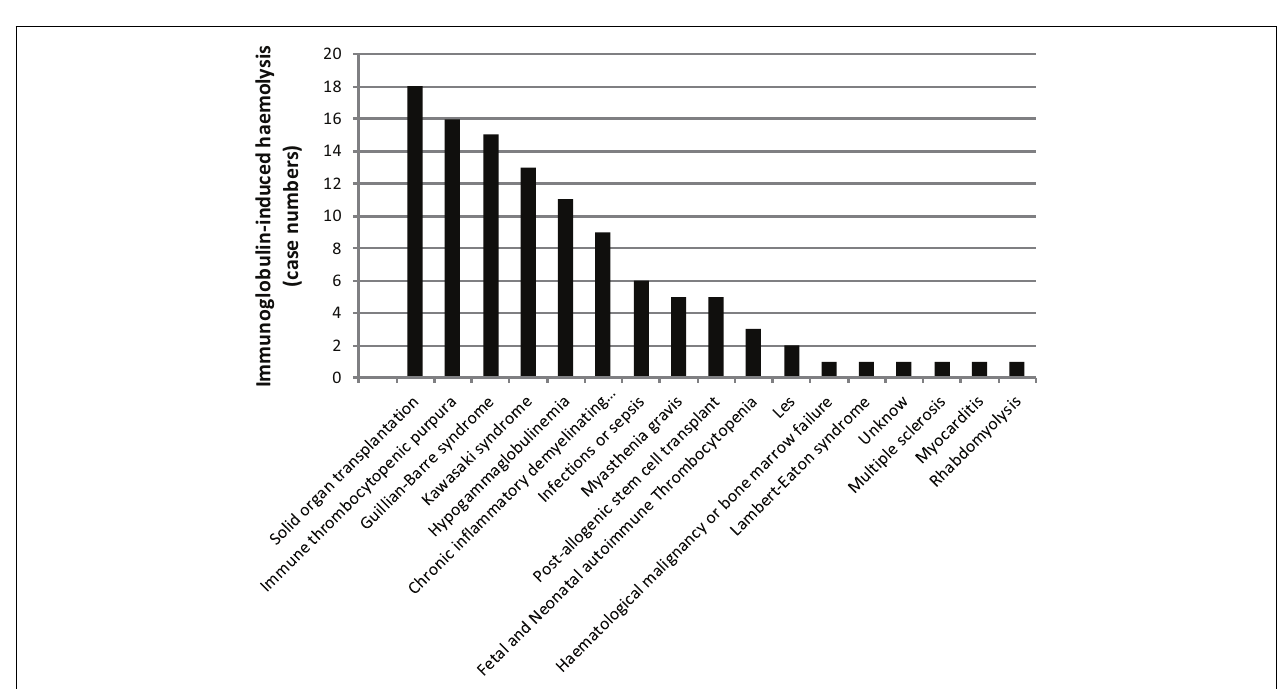
FIGURE 6 |The missing oxygen on the dark side: Ig-induced hemolysis in patients on Ig treatment . Black bars indicate the number of patients with a given clinical condition.